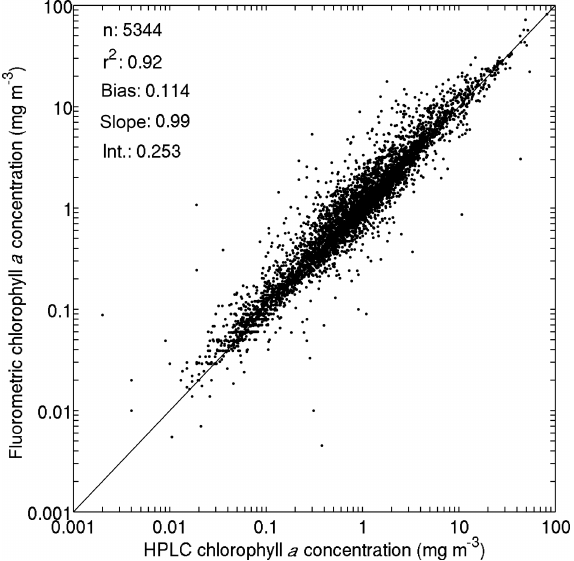
Figure 6. Comparison of coincident observations of chloro- phyll a concentration derived with different methods (chla_fluor and chla_hplc). The data were transformed prior to regression anal- ysis to account for their log-normal distribution.